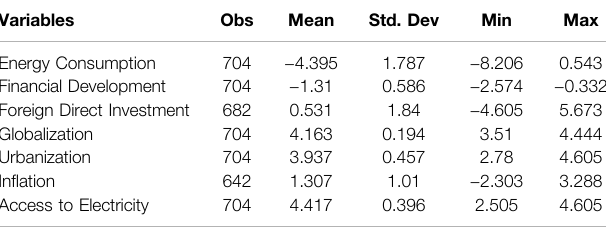
TABLE 2 | Descriptive